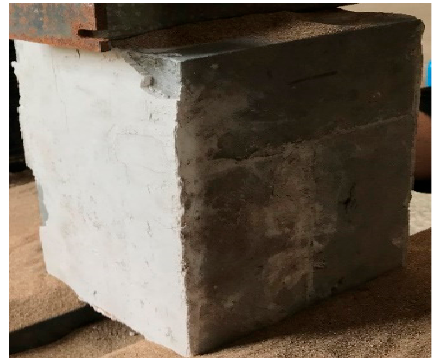
Figure 6. Shear stress test of the masonry.